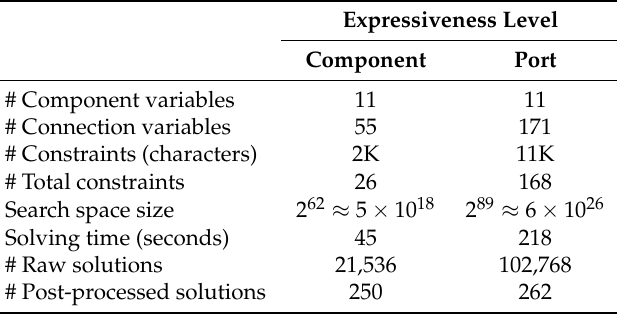
Table 4. Influence of the expressiveness level on the Prolog